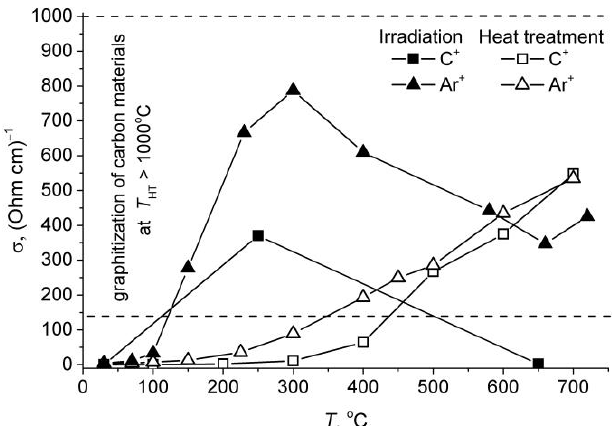
Figure 5. Dependences of the conductivity σ of the irradiated polycrystalline diamond layers on the irradiation temperature T and annealing T a .